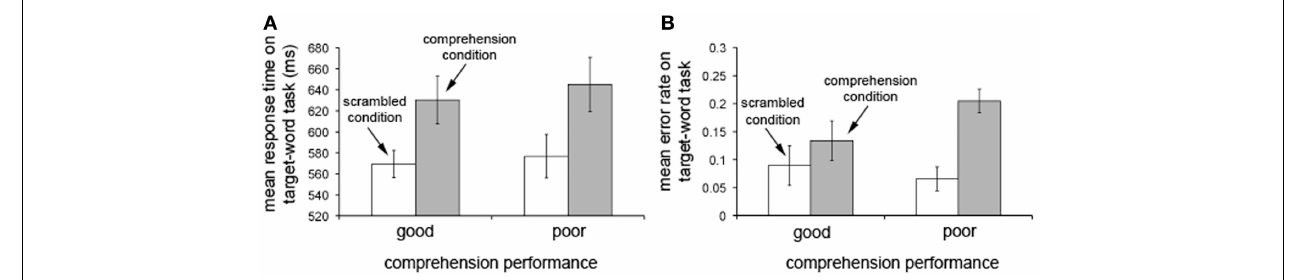
FIGURE 2 | Performance on the target-word detection task in the scrambled and comprehension conditions. Response times (A) and error rates (B) on the target-word detection task in the scrambled condition (white bars) and the comprehension condition (gray bars) for individuals with good ( N = 15; left bars) and poor ( N = 13; right